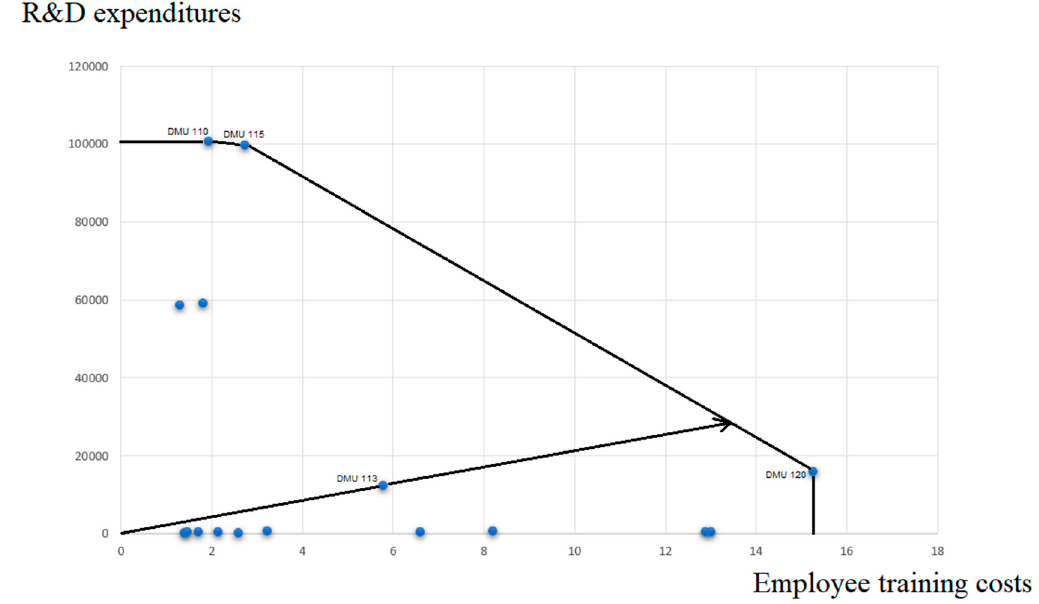
Figure 1. Evaluation of the Efficiency of Metal Manufacturers.